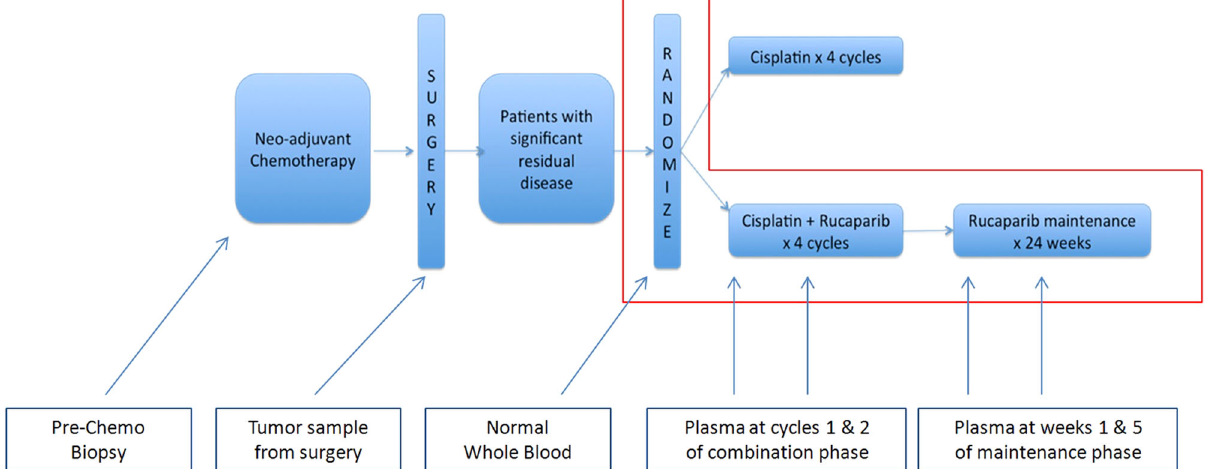
Fig. 1 Trial schema for BRE09-146.BRE09-146 was a Phase II clinical trial to evaluate 2-year disease-free survival (DFS) in TNBC patients, treated with either Cisplatin (Arm A) or Cisplatin in combination with PARP inhibitor Rucaparib (Arm B) after neoadjuvant chemotherapy. Tumor tissue, whole blood, and plasma from four time points after surgery were collected as indicated. In this trial, plasma samples were collected only in Arm B of (the area enclosed by the red rectangle ). Plasma samples were collected at four timepoints: Cycles 1 and 2 of the combination phase, and during weeks 1 and 5 of the maintenance